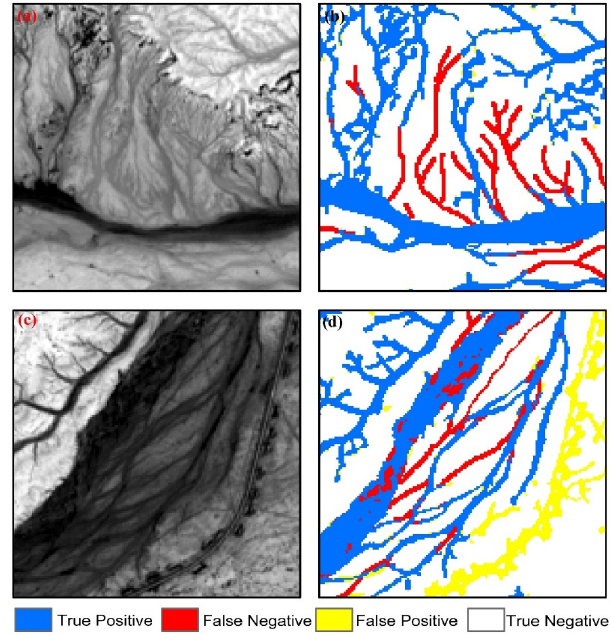
Figure 12. ( a , b) original image band and the commission and omission errors in the vicinity of linear false alarms in a local block; ( c , d) the other original image band and the commission and omission errors in the vicinity of linear false alarms in another local block.